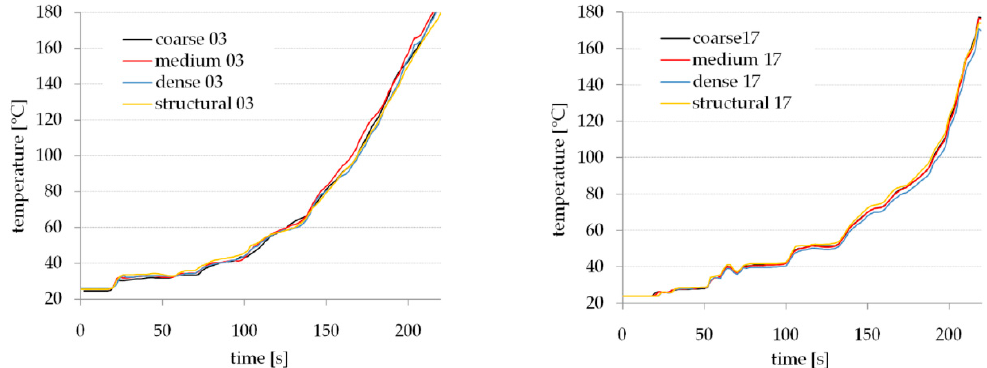
Figure 3. Comparison of time dependence of calculated temperature for different meshes for exper- iments #03 and #17. Temperature for the location of sprinkler 1 is shown.